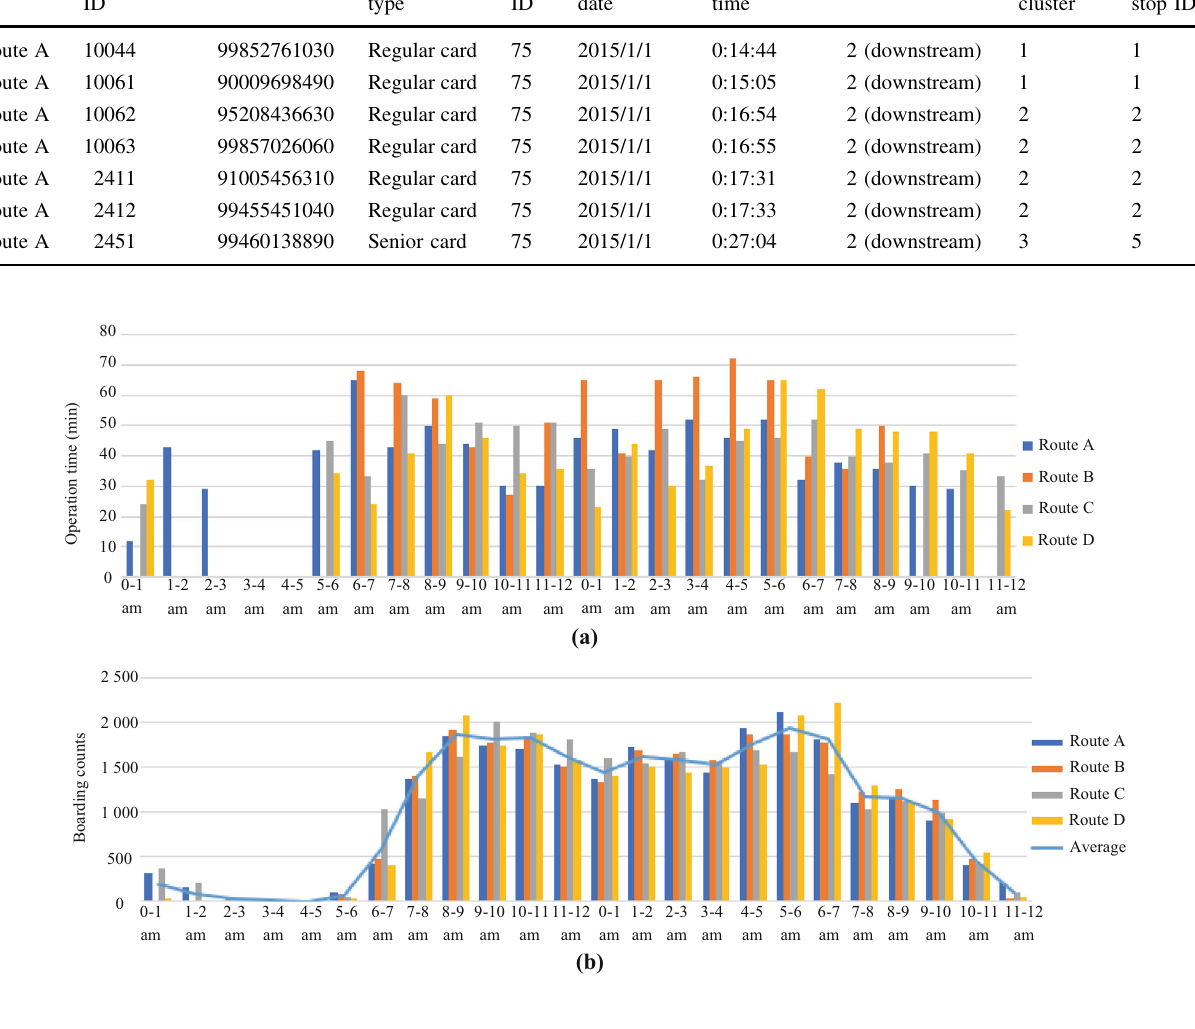
Fig. 4 Boarding counts and operation time during each time period. a Average bus operation time during each time period, b passenger boarding counts during each time